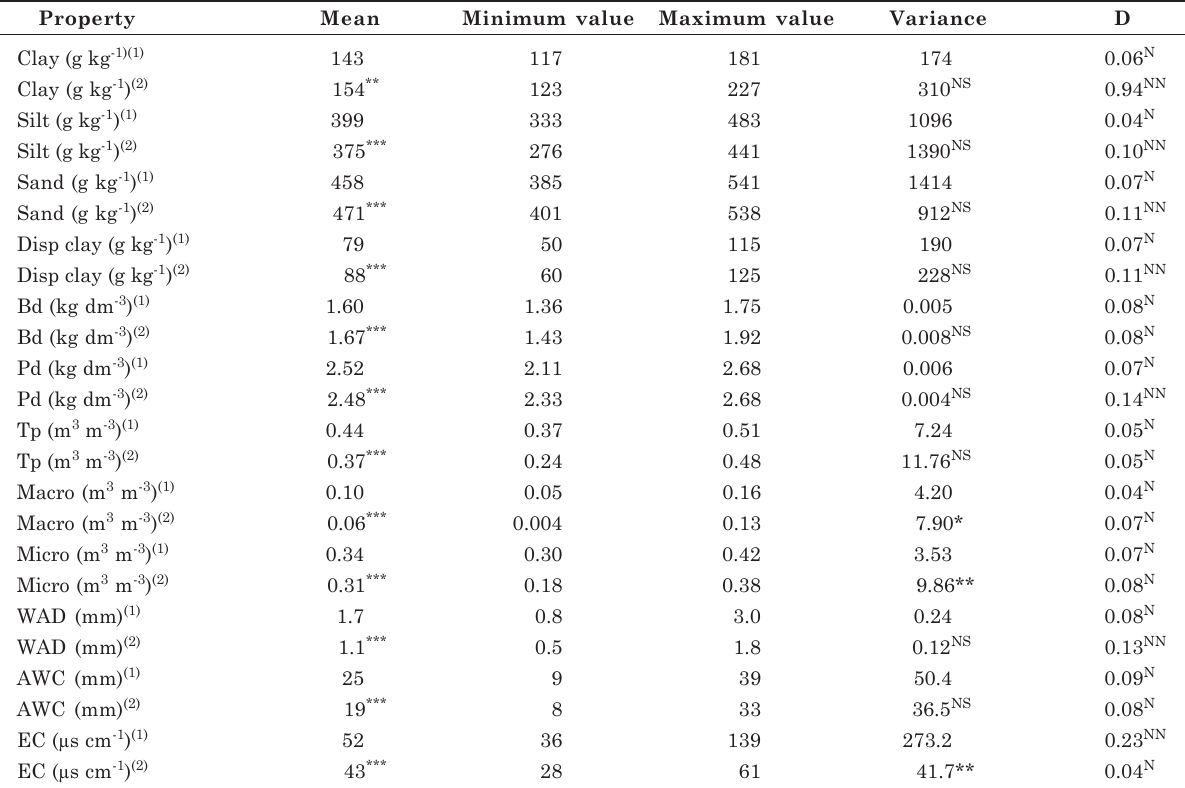
Table 1. Descriptive statistics, Kolmogorov-Sminorv and normality hypothesis tests for physical properties measured before and after land